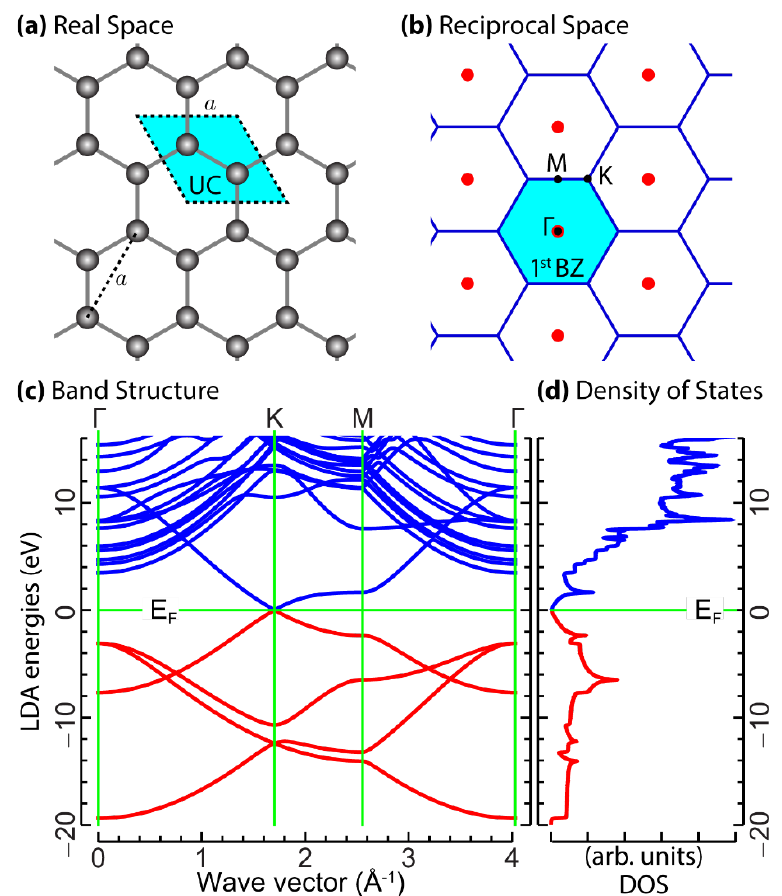
Figure 1. Structural and electronic properties of graphene obtained with PW DFT-LDA, as detailed in Section 2.1. ( a ) Real-space honeycomb lattice, unit-cell (UC), and crystal basis, with the C − C bond set to 1.420 Å . ( b ) Reciprocal space lattice, 1 st BZ, and irreducible 1 st BZ, delimited by the high- symmetry path ΓΚΜΓ . ( c ) LDA band structure along ΓΚΜΓ , with the Fermi level 𝐸 𝐹 set to zero. ( d ) LDA density of states